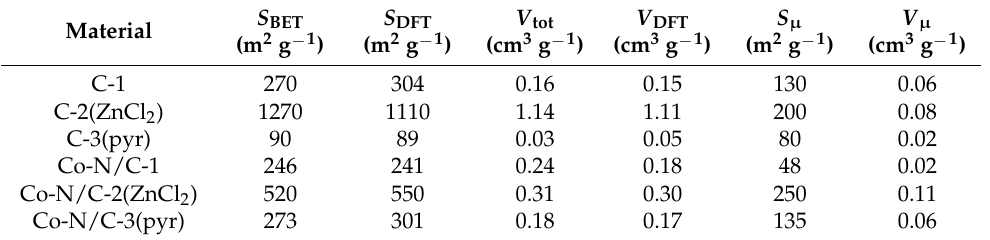
Table 3. Specific surface area values and porosity characteristics of selected